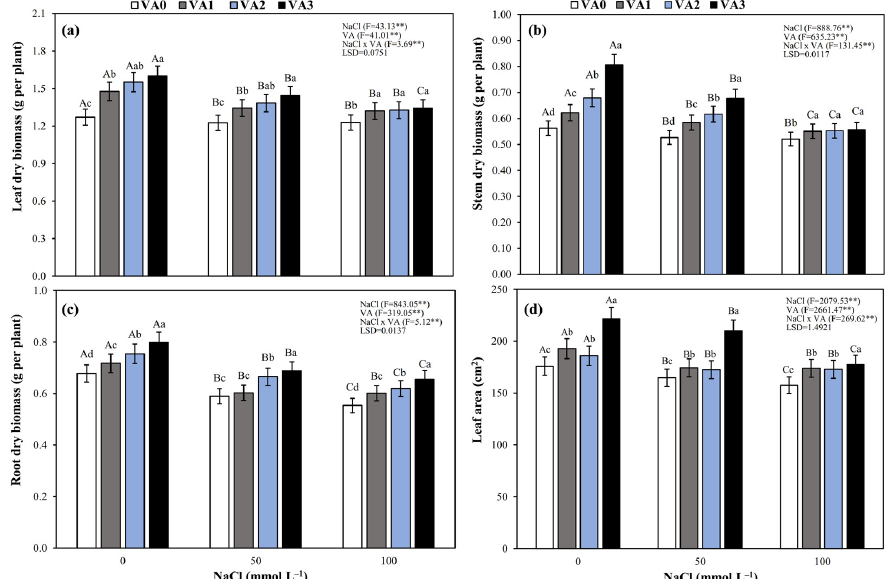
Figure 2. Leaf ( a ), stem ( b ), and root ( c ) dry mass and leaf area ( d ) of soybean plants under different levels of salt stress and VA application. Plants were submitted to four concentrations of VA (VA0, non-VA application; VA1, 0.4 mL L − 1 ; VA2, 0.8 mL L − 1 ; and VA3, 1.2 mL L − 1 ) under three levels of NaCl (0, 50, and 100 mmol L − 1 ). Data are mean ± SD (n = 5). Uppercase letters above bars indicate significant differences between different NaCl treatments at the same VA concentration. Lowercase letters above bars indicate differences among VA concentrations at the same NaCl concentration, according to LSD test ( p < 0.05). F values from ANOVA: ** p < 0.01.